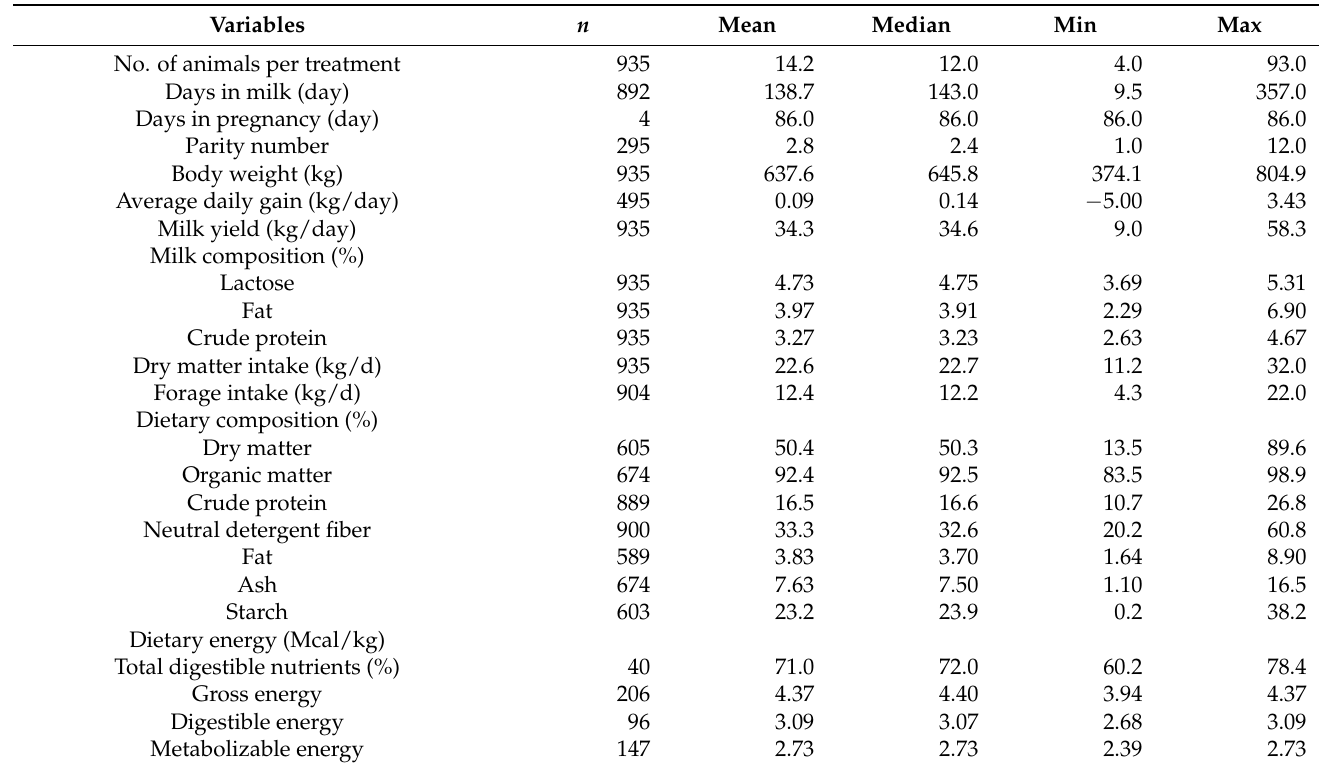
Table 1. Descriptive statistics of the literature database used for the final model evaluation ( n =